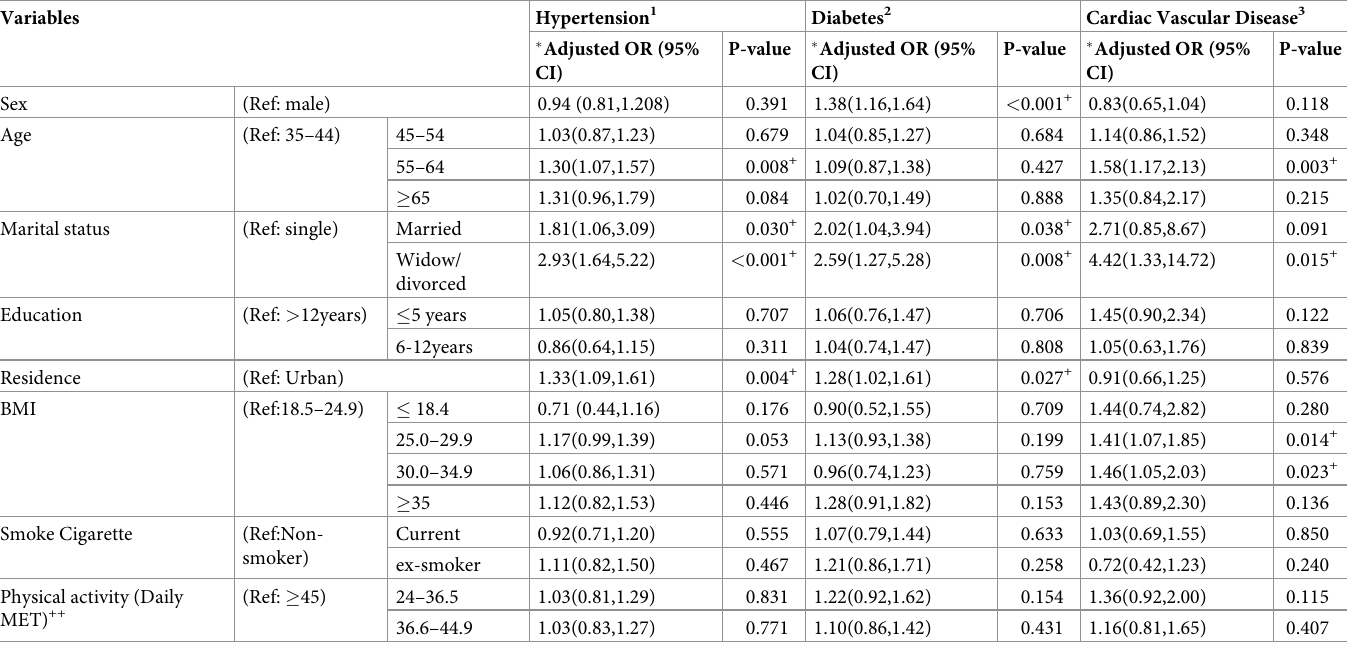
Table 8. Multivariable analysis of some of the factors affecting hypertension, diabetes, and heart diseases in the current study.